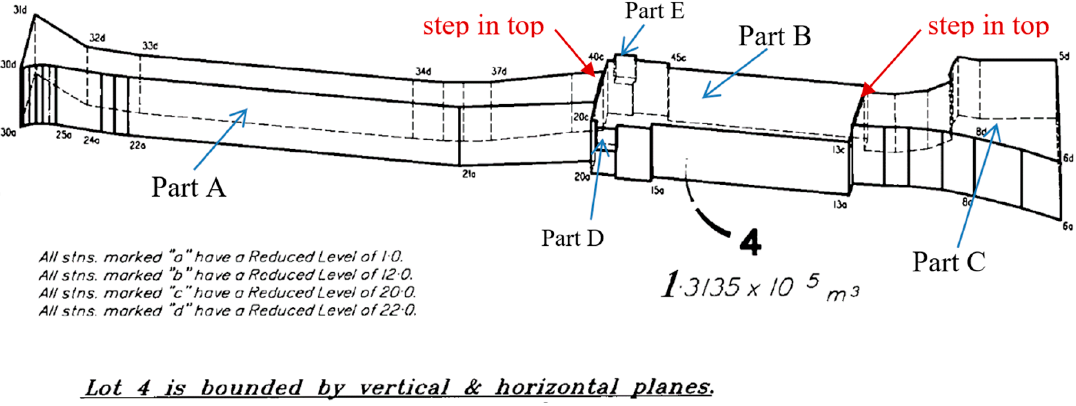
Figure 14. A Spatial unit that can be encoded in many ways.